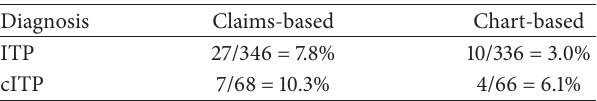
Table 4: Prevalence of congenital anomalies by ITP and cITP and by source.